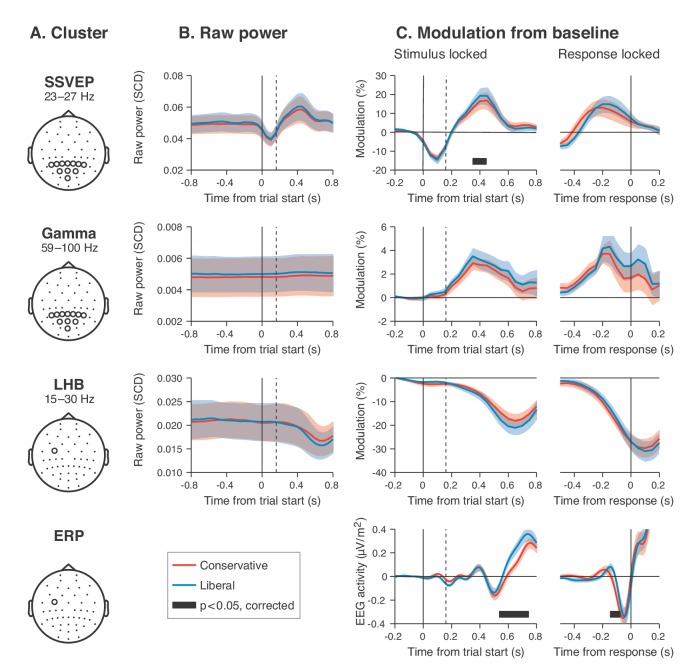
Experimental task manipulations affect the time course of stimulus- and motor-related EEG signals, but not its starting point.Raw power throughout the baseline period and time courses of power modulation time-locked to trial start and button press. (A) Relevant electrode clusters and frequency ranges (from Figure 3): Posterior SSVEP, Posterior gamma and Left-hemispheric beta (LHB). (B) The time course of raw power in a wide interval around the stimulus –0.8 to 0.8 s ms for these clusters. (C) Stimulus locked and response locked percent signal change from baseline (baseline period: –0.4 to 0 s). Error bars, SEM. Black horizontal bar indicates significant difference between conditions, cluster-corrected for multiple comparison (p<0.05, two sided). SSVEP, steady state visual evoked potential; LHB, left hemispheric beta; ERP, event-related potential; SCD, scalp current density.